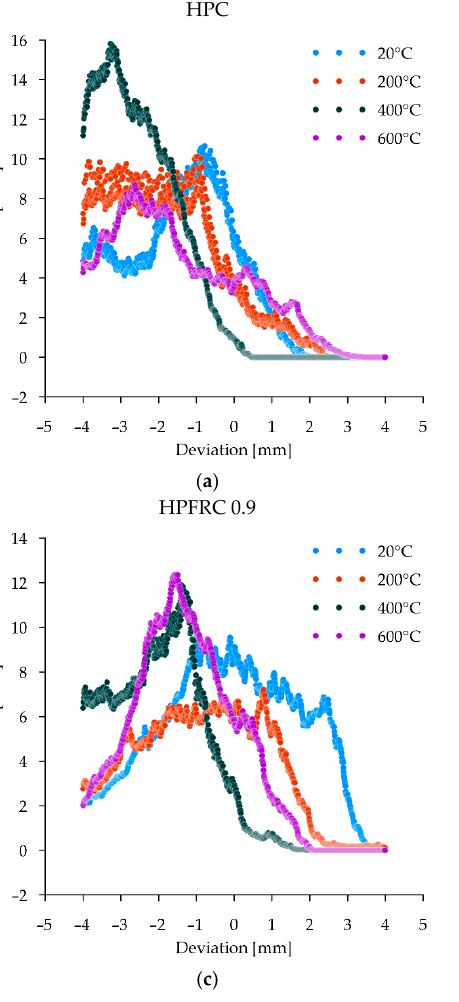
Figure 10. Deviation histograms: ( a ) HPC; ( b ) HPFRC 0.6; ( c ) HPFRC 0.9; ( d ) HPFRC 1.1.